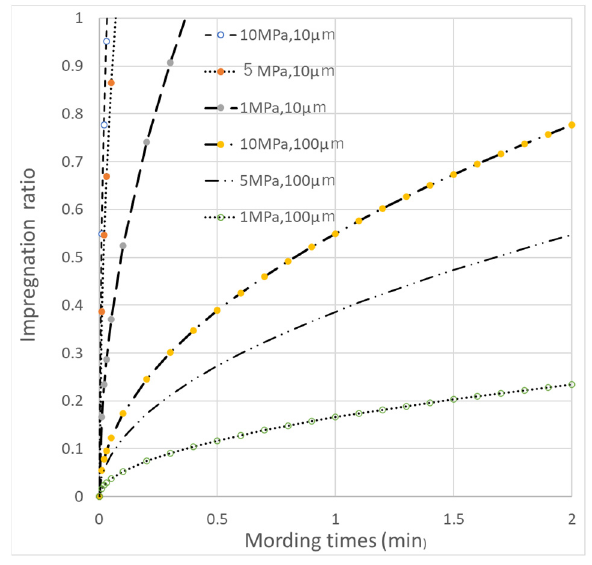
Figure 17. Impregnation ratio as a function of molding pressure and l 0 .